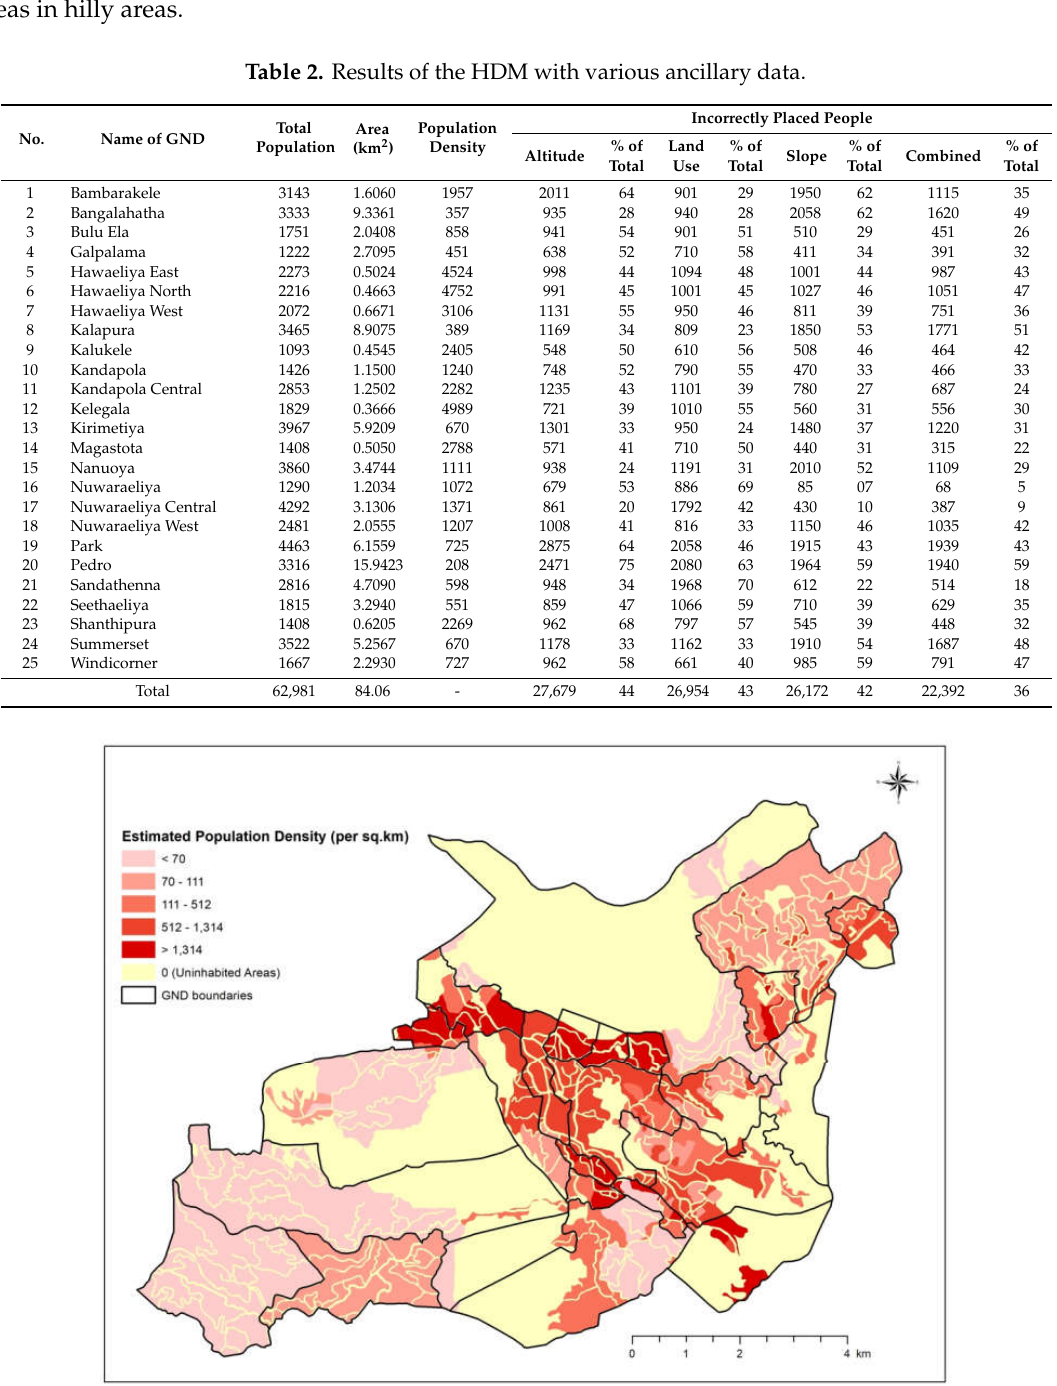
Figure 8. Population estimation using the altitude-based dasymetric mapping.